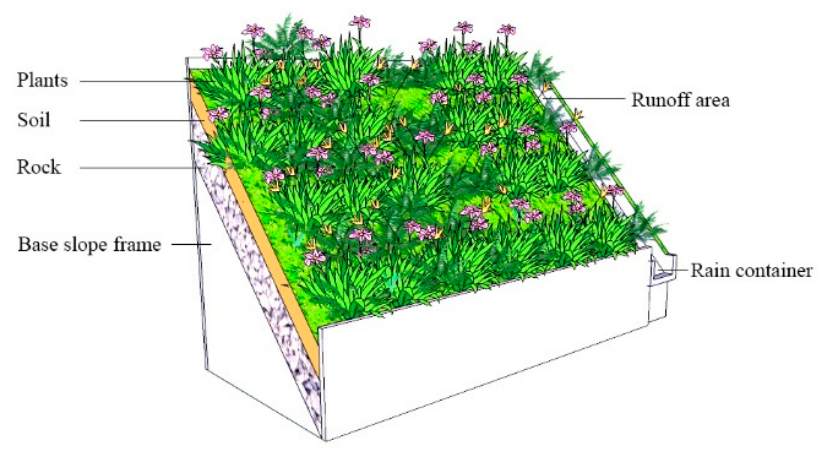
Figure 2. Structural diagram of the slope system.